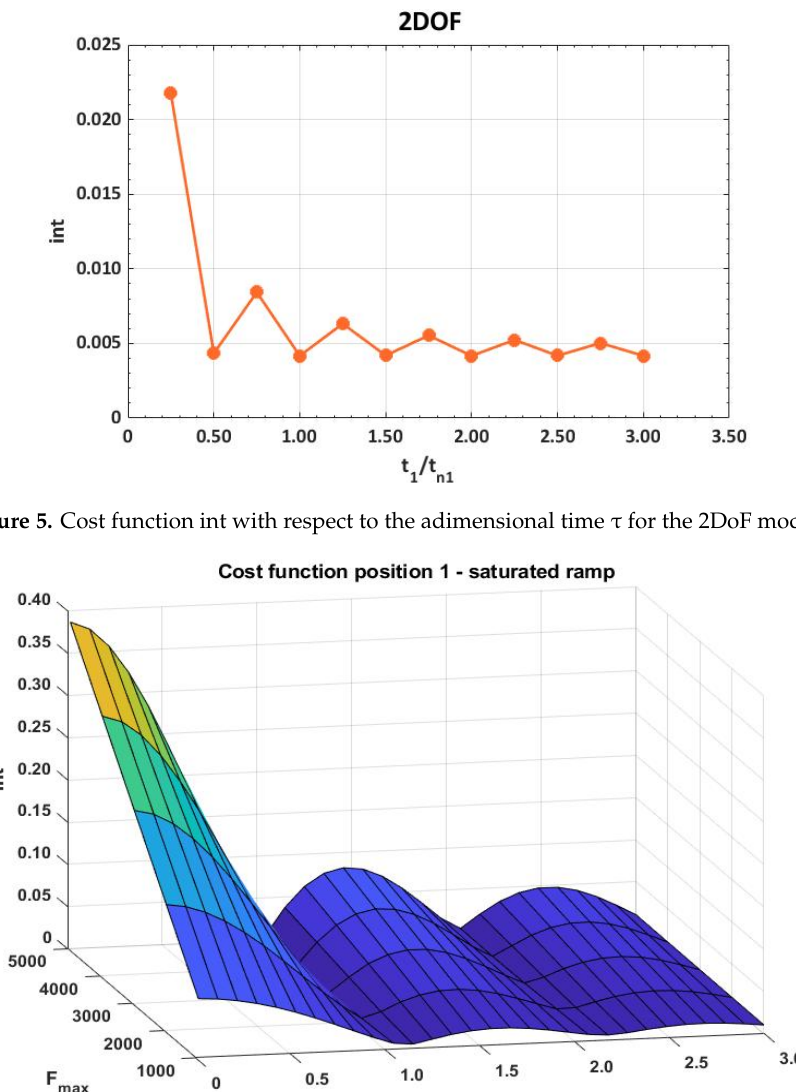
Figure 4. Cost function int with respect to the adimensional time τ for the 1DoF model. Similarly, the multibody model was configured to have two degrees of freedom allowing the